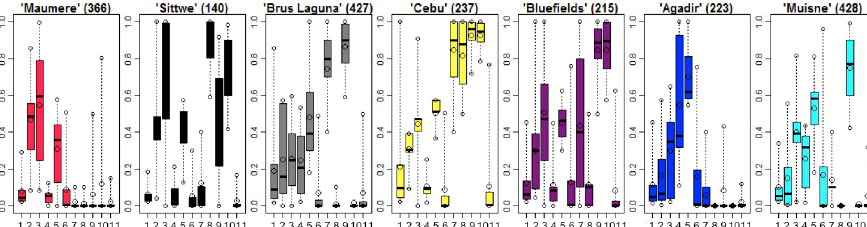
Fig 5. Box plots of the vulnerability profiles. They show the variation in indicator values (all indicator values are between 0 and 1) in each profile. The order of the indicators is identical to Fig 4. The boxes present the 25–75 percentile range of the indicator values; the circles at the end of the dotted lines indicate the 5- and 95-percentile, while the larger circle between them indicates the arithmetic mean; the black band in the box indicates the median value. The number of grid cells in a profile is indicated at the top of each